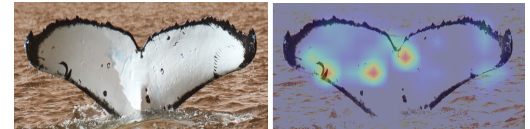
Figure 3. Grad-CAM results for selected feature map resulting of the fourth residual block of the ResNet101